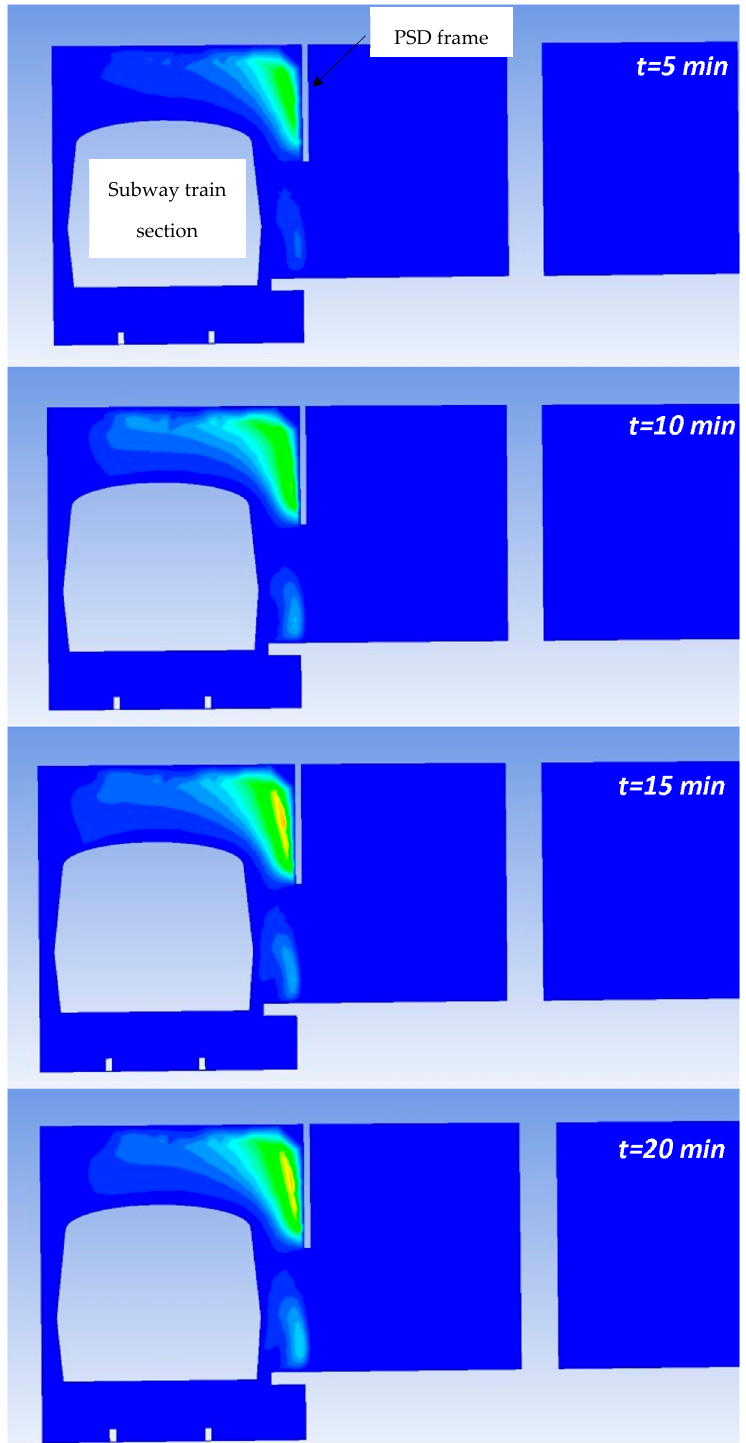
Figure 19. Temperature contours (°C)—cross section through the door of the PSD system near the fire outbreak (minutes 5–20).